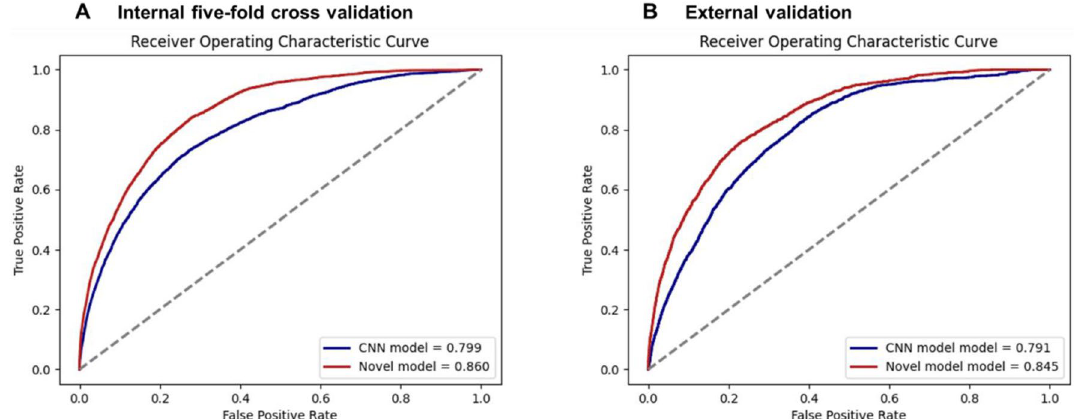
Figure 3. Diagnostic performances of deep learning models in the internal five-fold cross validation and external validation. ( A ) In the internal five-fold cross validation, the vision transformer (ViT)-based model significantly outperformed the convolutional neural network (CNN)-based model (p < 0.001). ( B ) In the external validation, the ViT-based model also showed significantly better performance than the CNN-based model (p < 0.001), showing better generalizability in unseen data distribution.